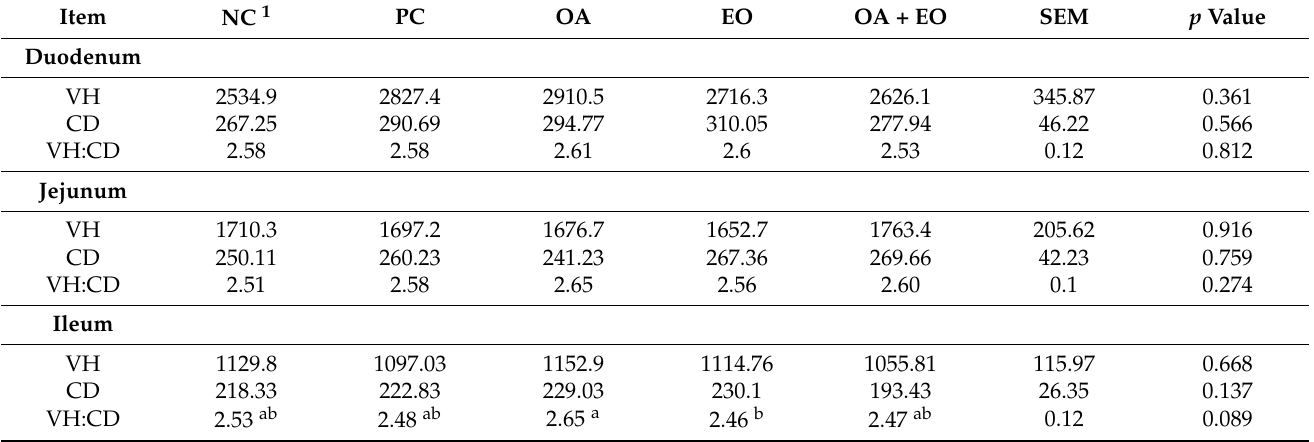
Table 5. Effects of individual or combination of organic acids and essential oils on the villus height (VH, µ m), crypts depth (CD, µ m), and VH:CD in the duodenum, jejunum, and ileum of broiler chickens on D